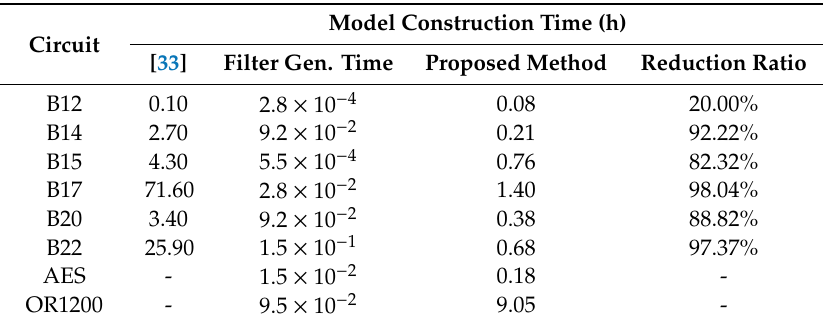
Table 6. Model construction time.